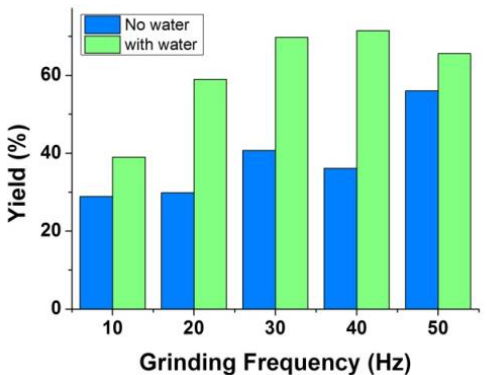
Figure 5. Comparison of yields of Ni-BTC samples obtained with and without addition of water (1 mL).